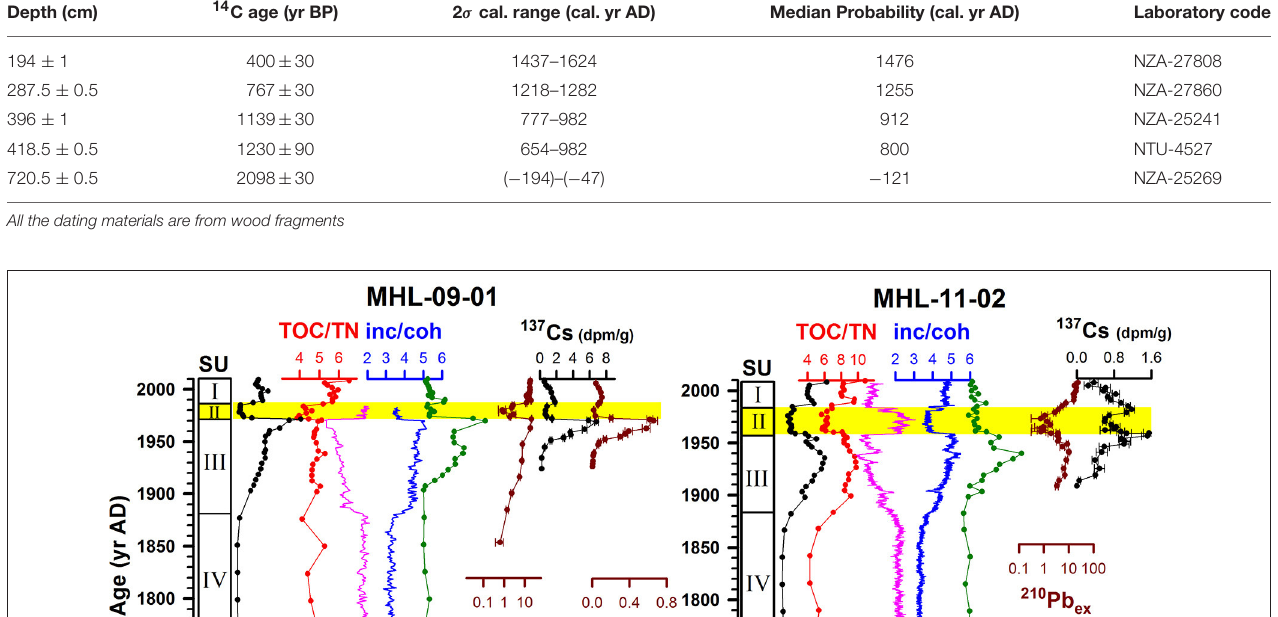
TABLE 2 | Radiocarbon dates and corresponding calibrated ages of the upper 720cm in core MHL-5A from the Lake Meihua. Depth (cm) 14 C age (yr BP)